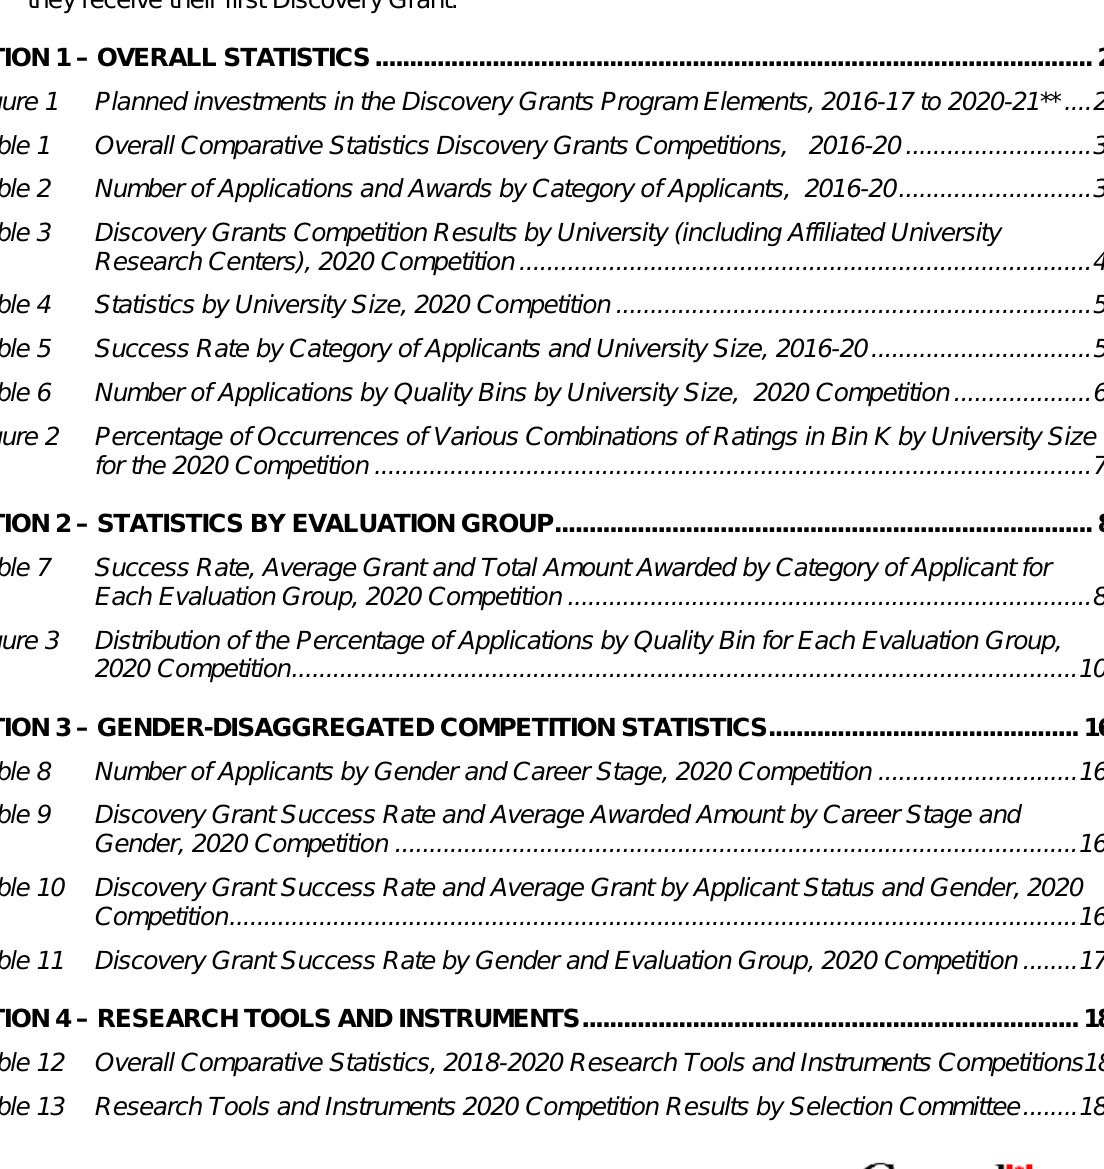
Planned investments in the Discovery Grants Program Elements, 2016-17 to 2020-21** .... 2